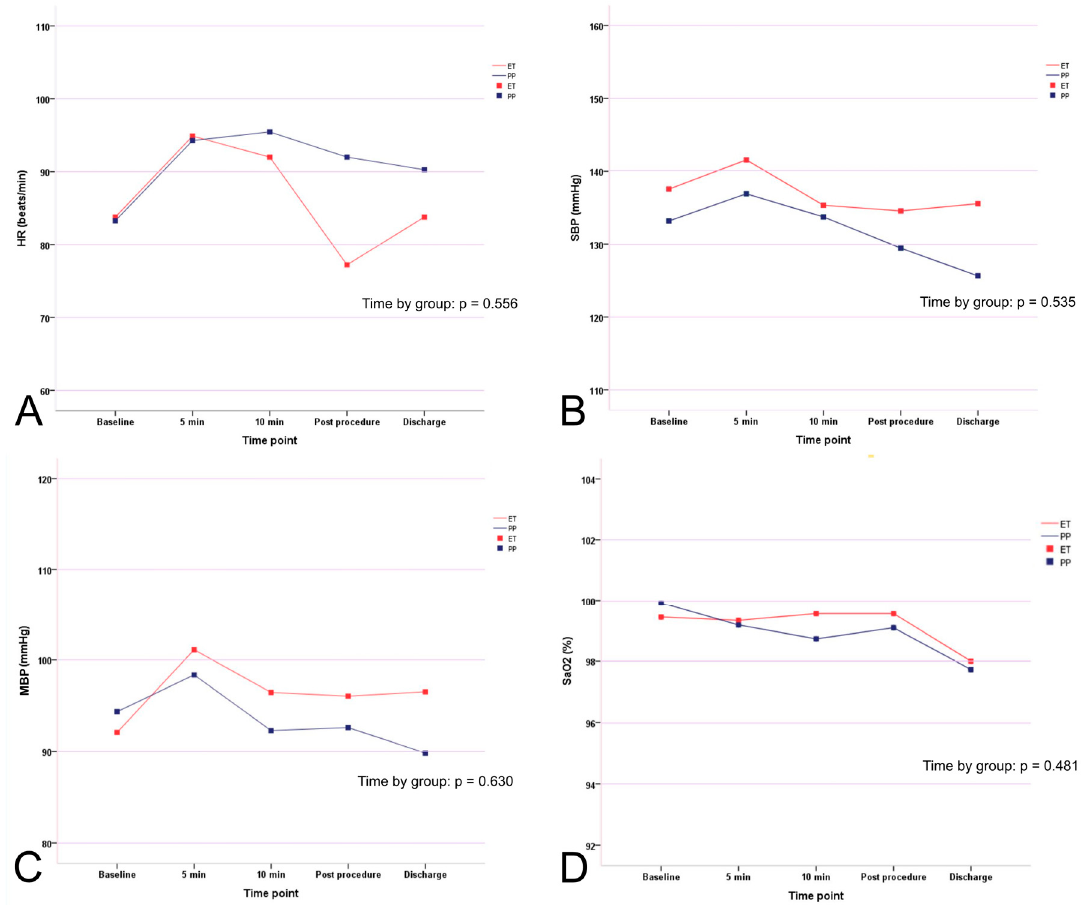
Figure 2. Time course showing changes in heart rate, blood pressure, and oxygen saturation. Mean values of ( A ) heart rate (beats/min), ( B ) systolic blood pressure (mmHg), ( C ) mean blood pressure (mmHg), and ( D ) arterial oxygen saturation (%), at baseline (at least 15 min before the initial drug administration), 5 and 10 min after initiating sedation during endoscopy, awake time, and at discharge from the endoscopy unit.